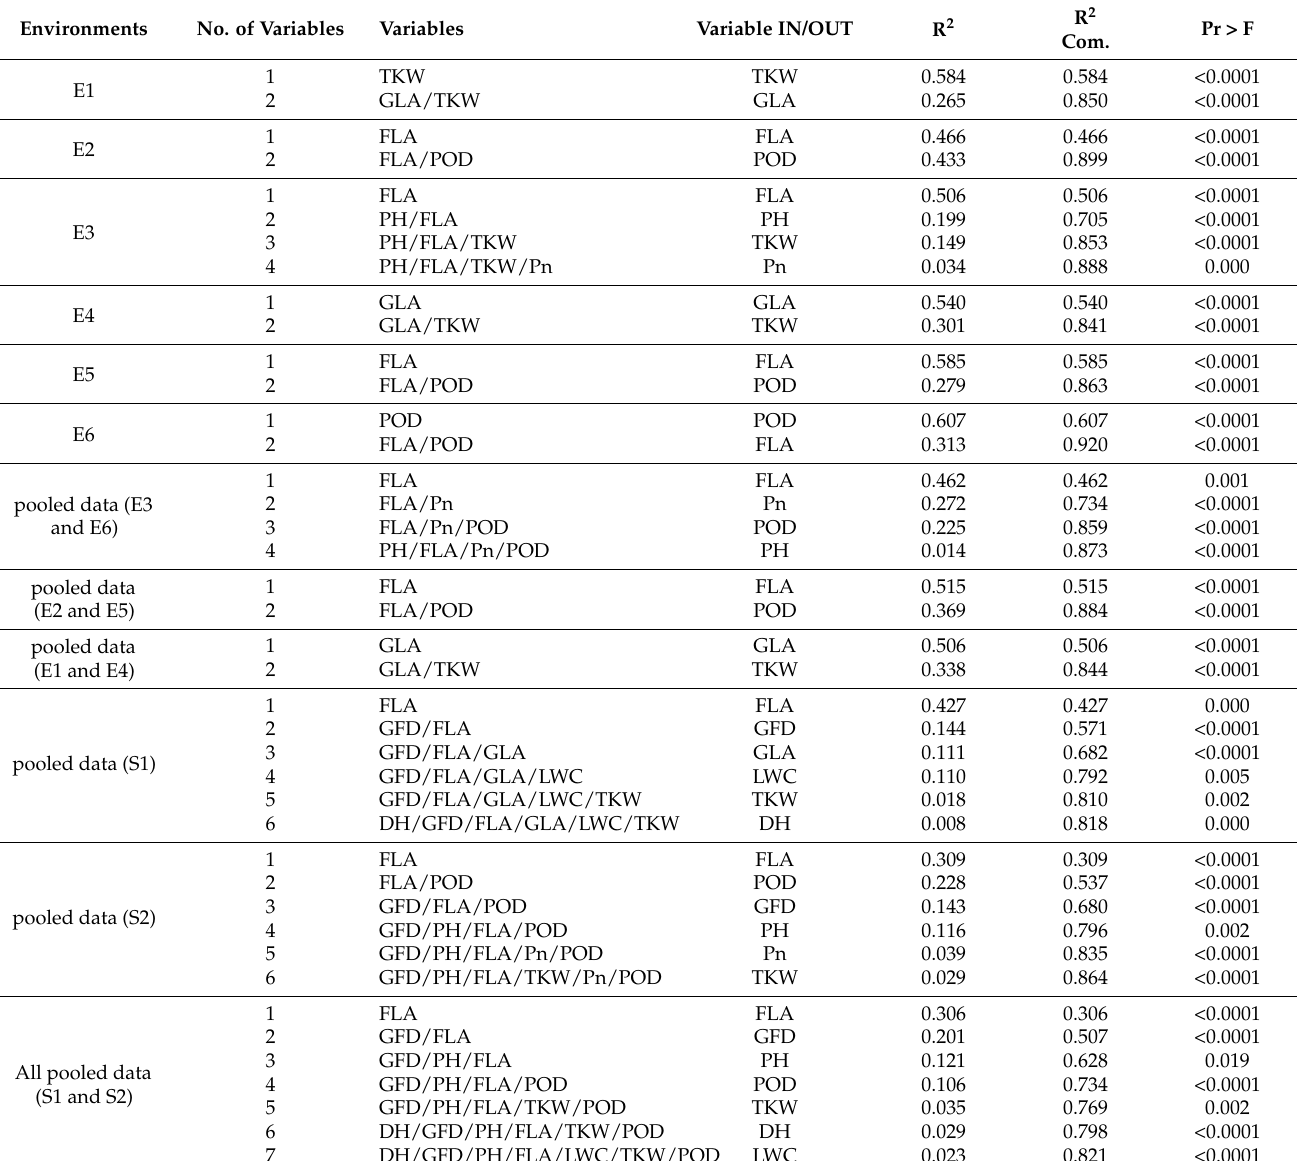
Table 3. Stepwise regression analysis for grain yield (dependent variable) with 22 traits (independent variables) for the single data per environment, across environments, and across all pooled